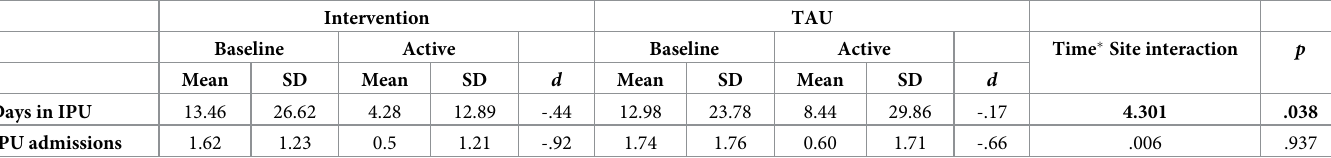
Table 3. Baseline and active phase means and time � site interaction statistics for total bed days and total number of admissions to an inpatient unit (IPU). n =